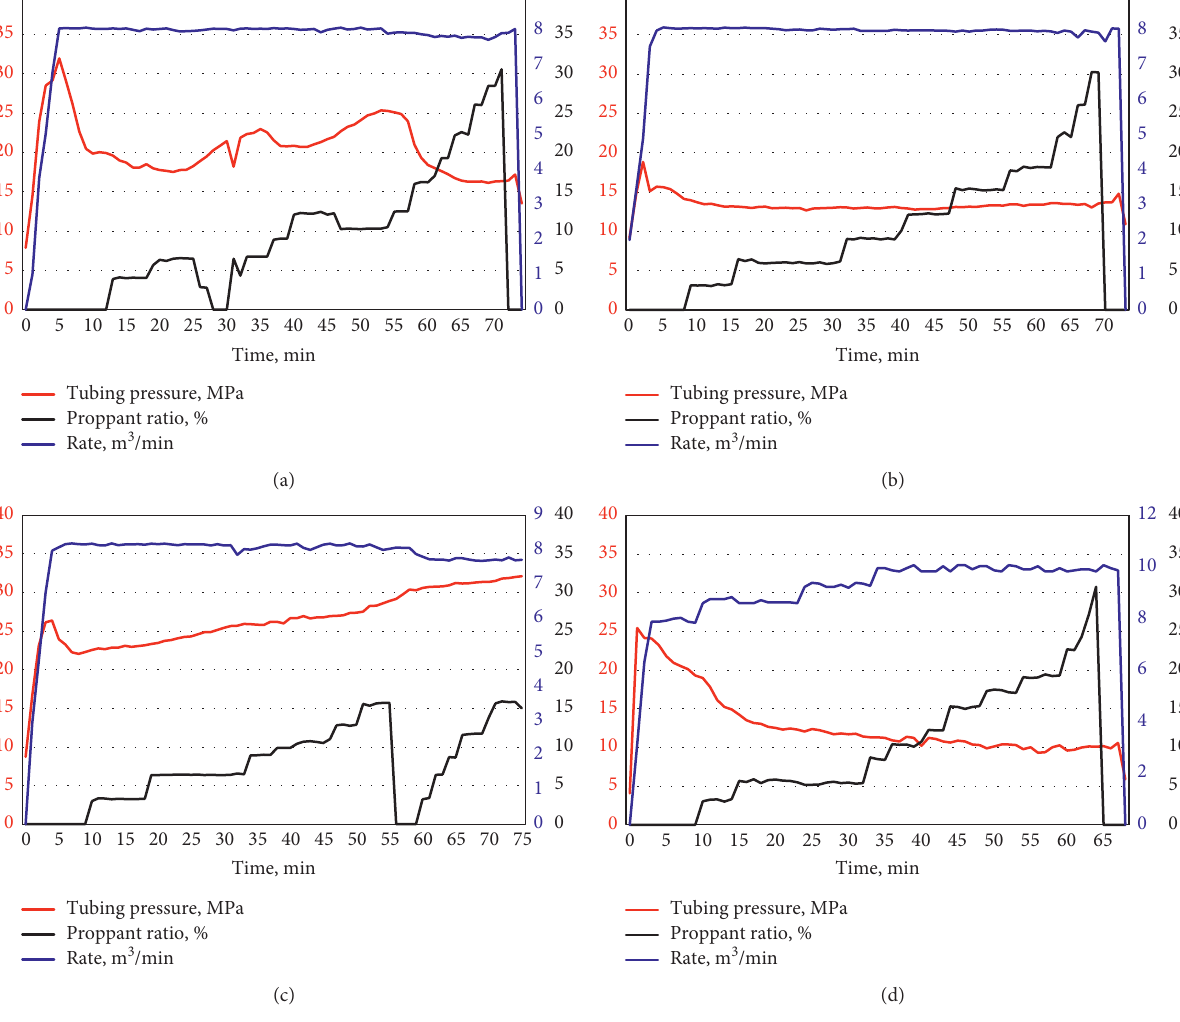
Figure 5: The four typical operation curves. (a) Fluctuating operation curve. (b) Stable operation curve. (c) Ascending operation curve. (d) Descending operation curve.